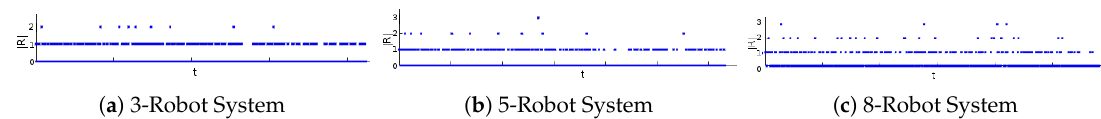
in any connected component over R u | | (on average) that are simultaneously deciding along R u | |